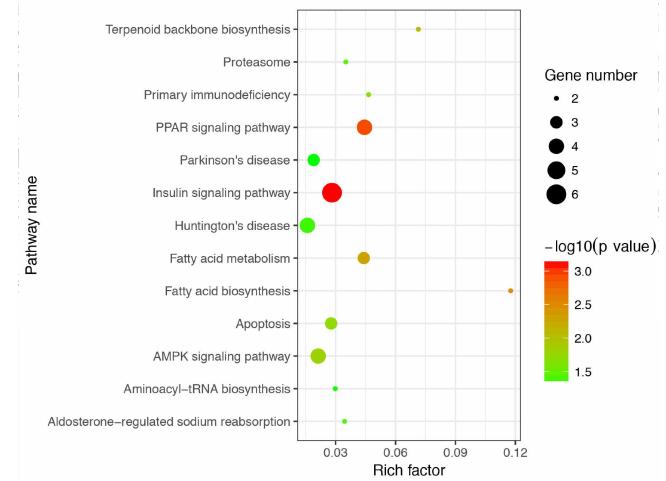
Figure 4. Kyoto Encyclopedia of Genes and Genomes (KEGG) enrichment analysis of differentially expressed genes (DEGs). The x axis represents rich factor and the y axis represents pathway. Size and color of the bubble represent the amount of differentially expressed genes enriched in pathway and enrichment significance,